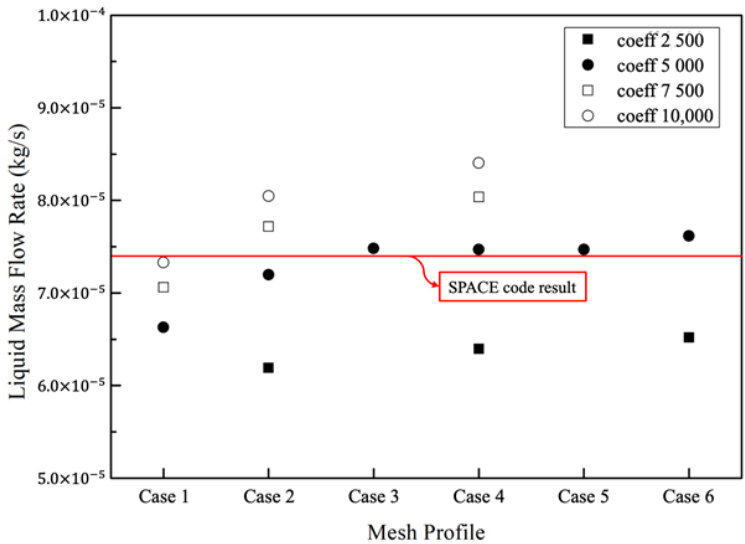
Figure 3. Results of the validation with the SPACE code.